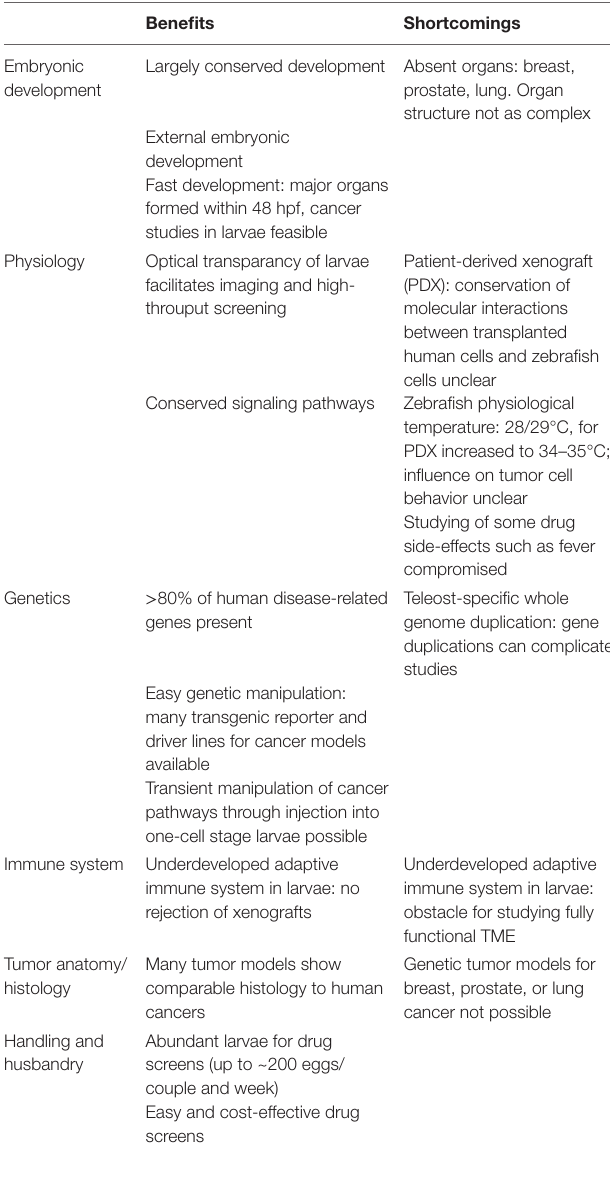
TABLe 2 | Benefits and shortcomings of the zebrafish in cancer